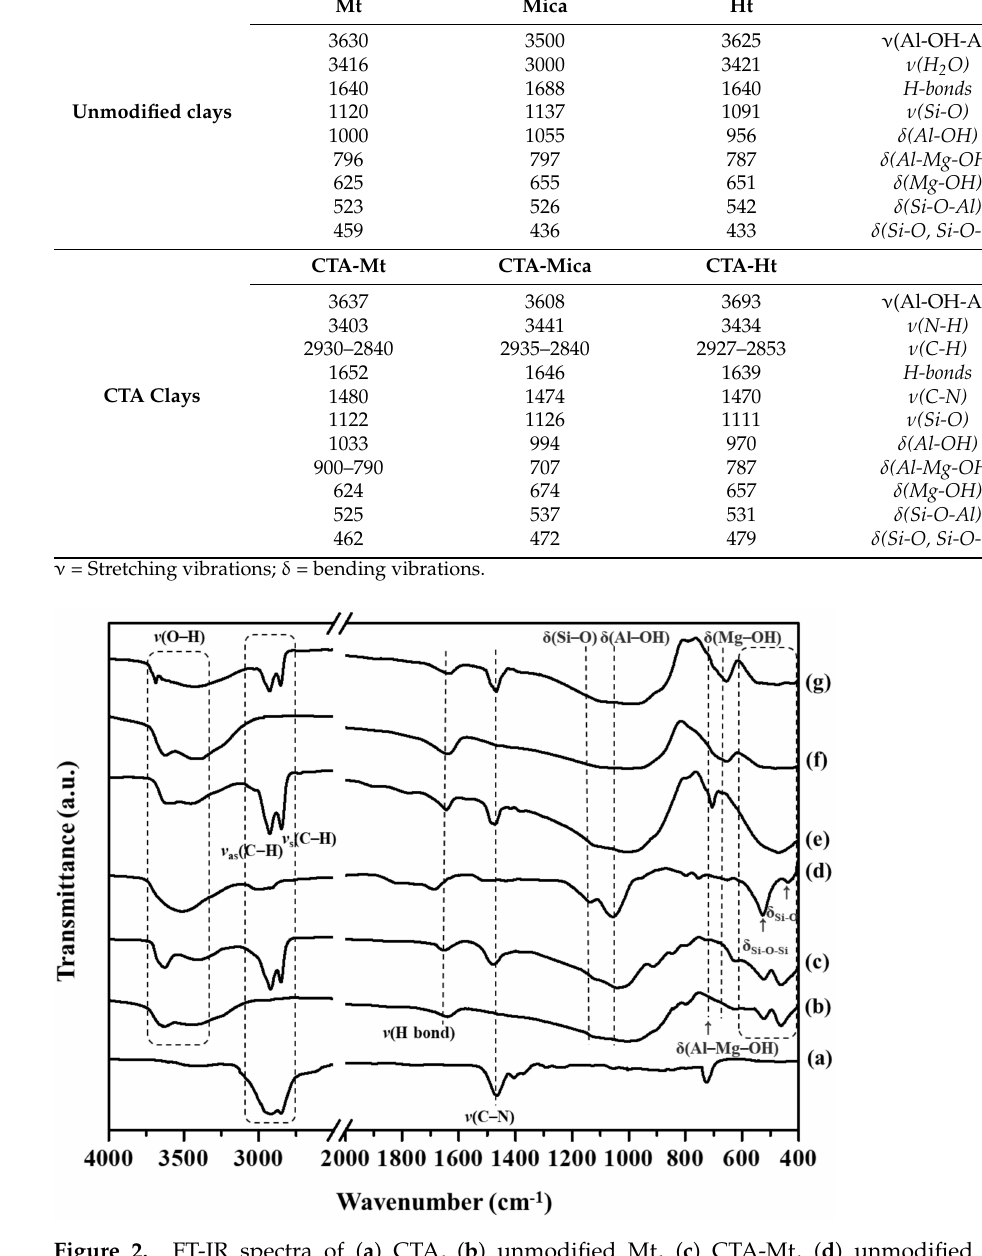
Figure 2. FT-IR spectra of ( a ) CTA, ( b ) unmodified Mt, ( c ) CTA-Mt, ( d ) unmodified mica, ( e ) CTA-Mica, ( f ) unmodified Ht, and ( g )